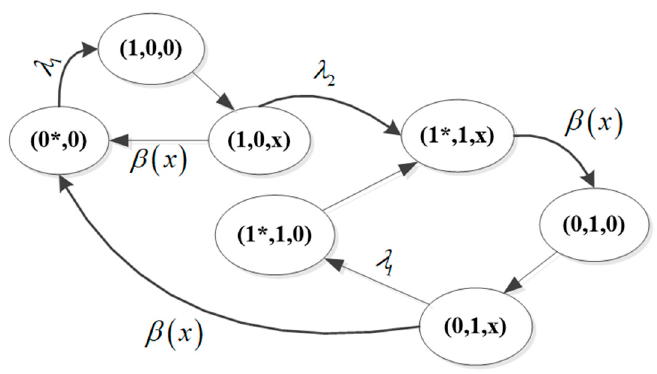
Figure 1. Graph of the state transition.